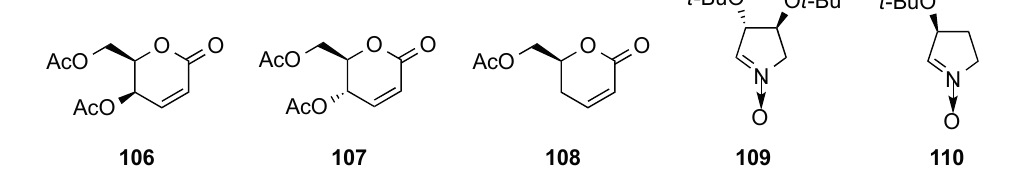
Figure 3. δ -Unsaturated lactones and chiral